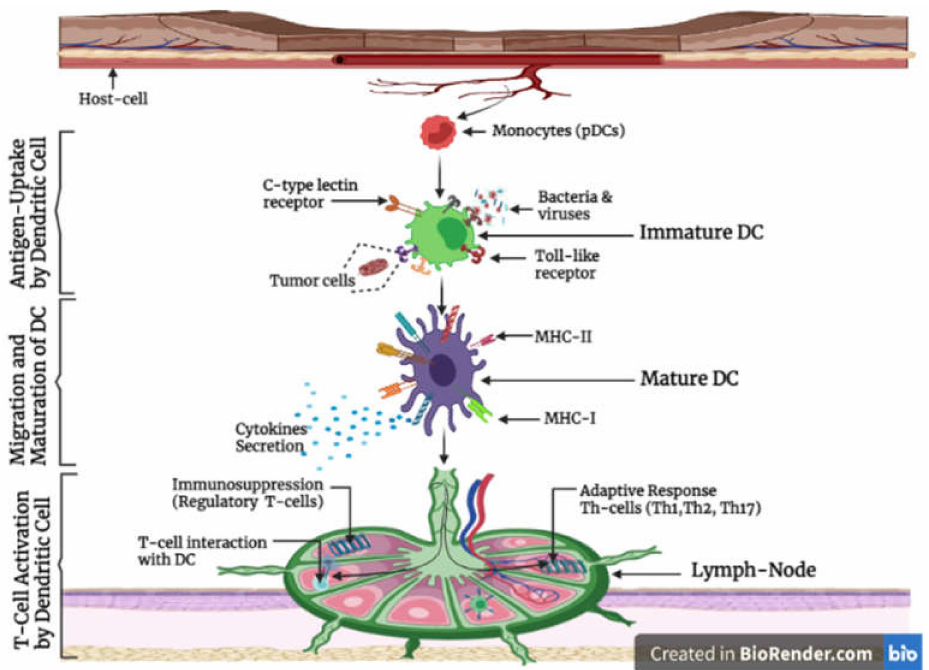
Figure 2. Antigen uptake, migration, maturation and T-cell activation by the dendritic